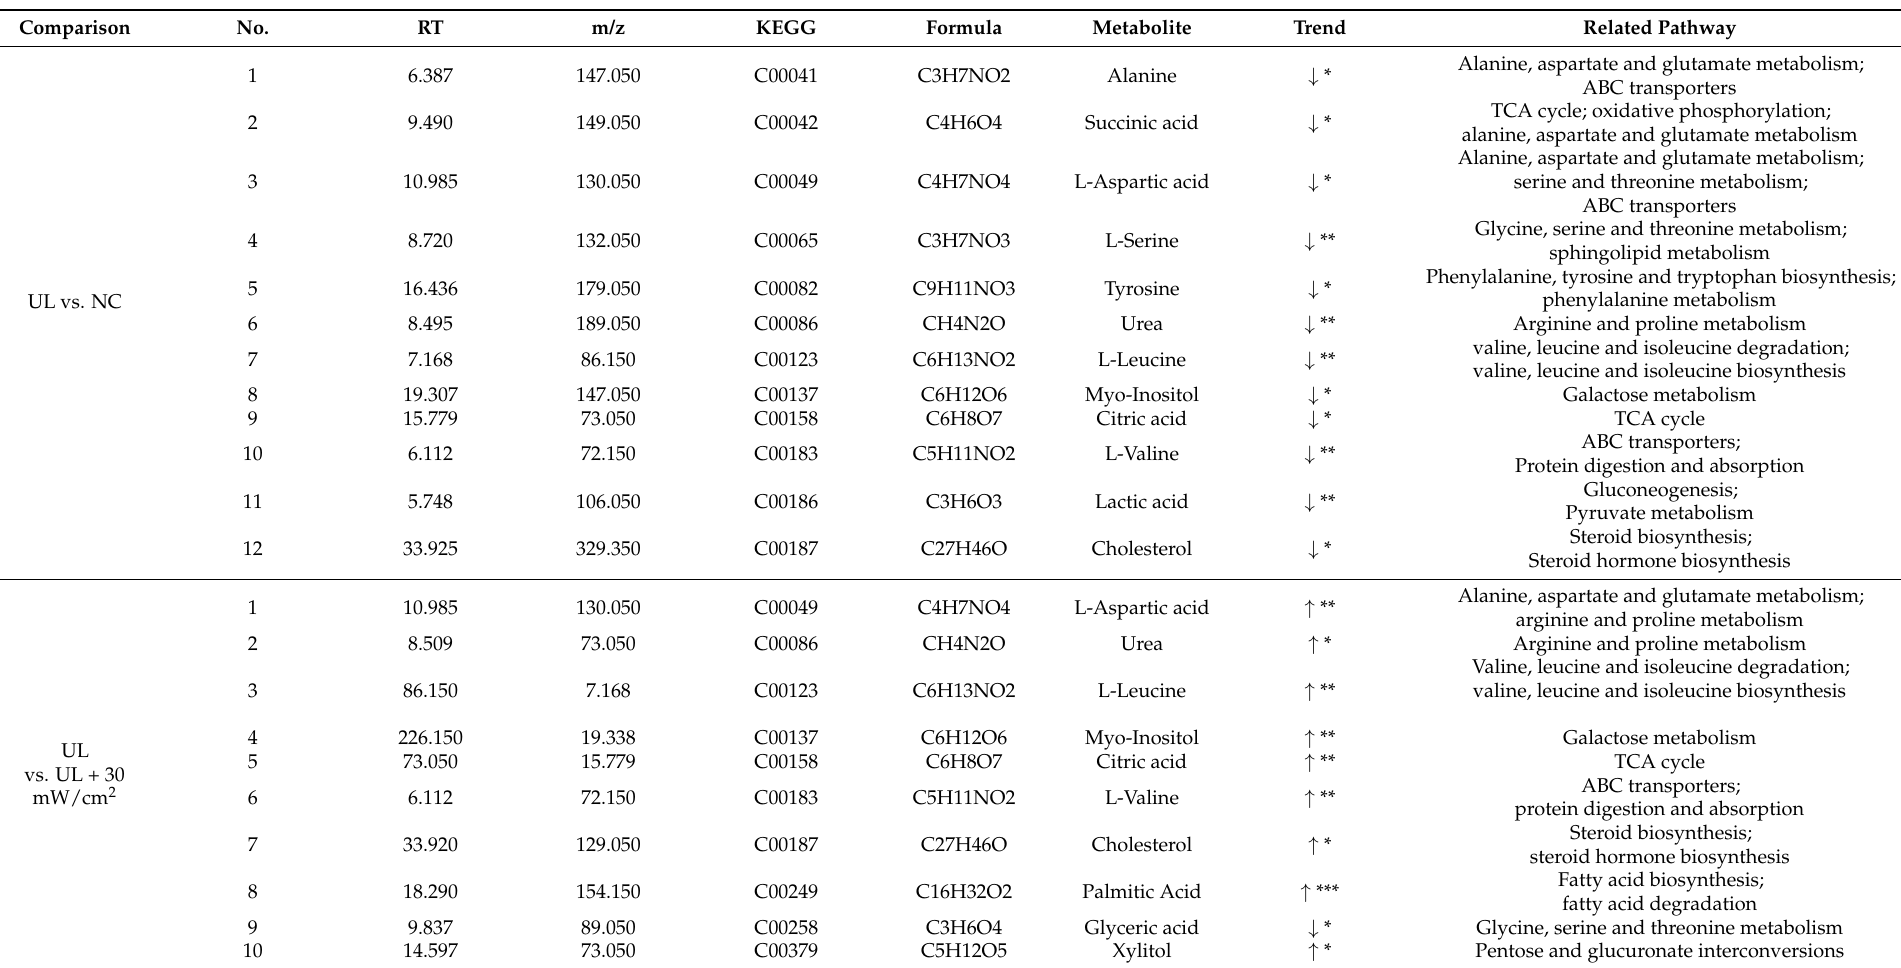
Table 1. Potential biomarkers and the